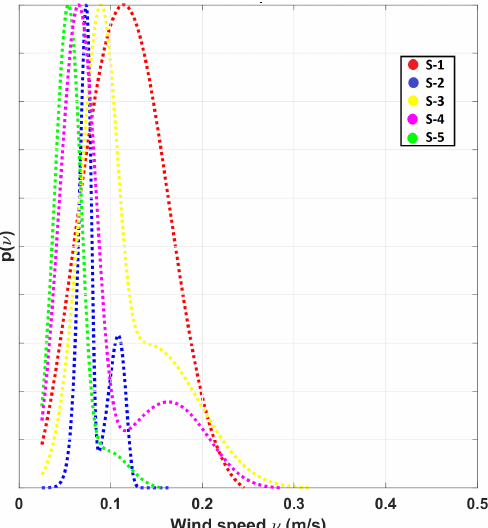
Figure 7. Bi-modal Weibull distributions bWB ( ν ) computed at the different locations of the sensing nodes in